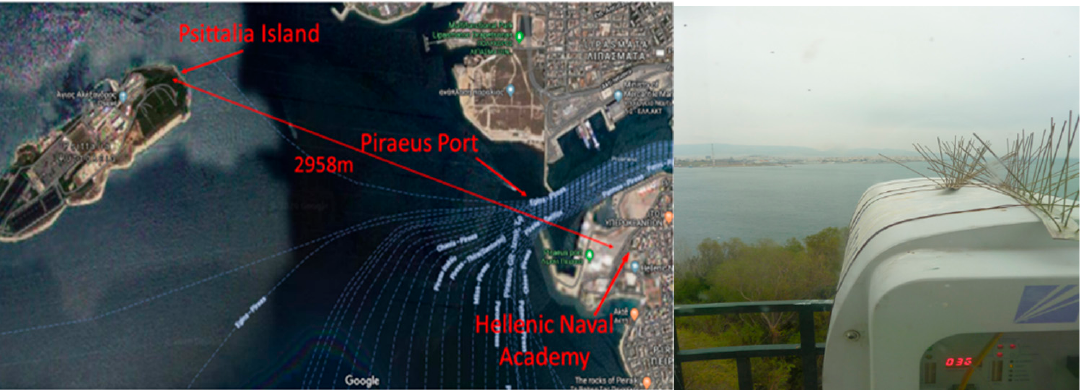
Figure 1. The maritime free-space optical (FSO) link propagation path ( left ) and the MRV TS5000/155 FSO terminal on the lighthouse of Psitalia Island ( right ). On the upper left back side of the system, the received signal strength indicator (RSSI)